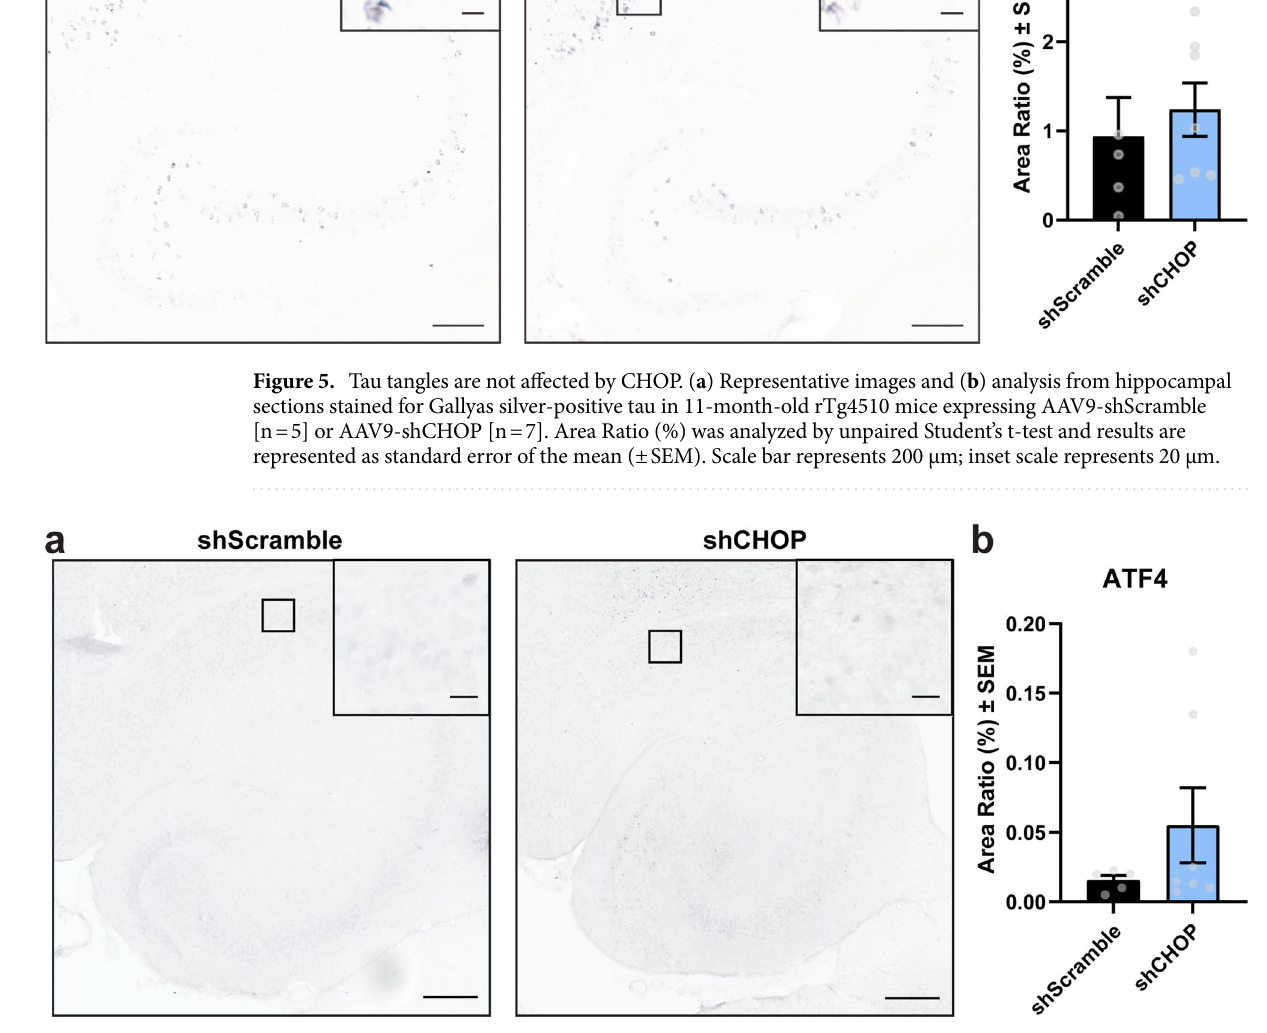
Figure 6. ATF4 levels are unchanged in shCHOP-injected mice. ( a ) Representative images and ( b ) analysis from hippocampal sections stained for ATF4 in 11-month-old rTg4510 mice expressing AAV9-shScramble [n = 5] or AAV9-shCHOP [n = 7]. Area Ratio (%) was analyzed by unpaired Student’s t-test and results are represented as standard error of the mean (± SEM). Scale bar represents 200 µm; inset scale represents 20